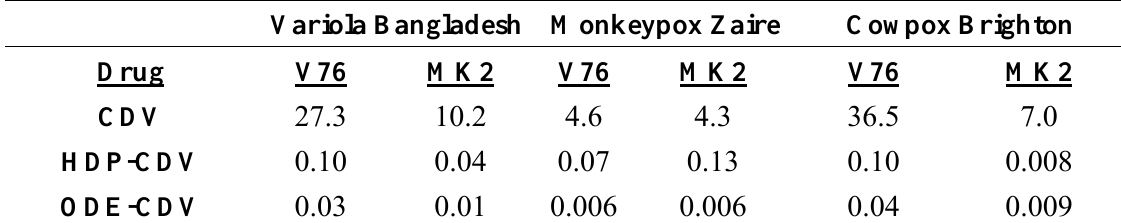
Table 1. Antiviral Activity of HDP-CDV and ODE-CDV Against Variola, Monkeypox and Cowpox, in vitro